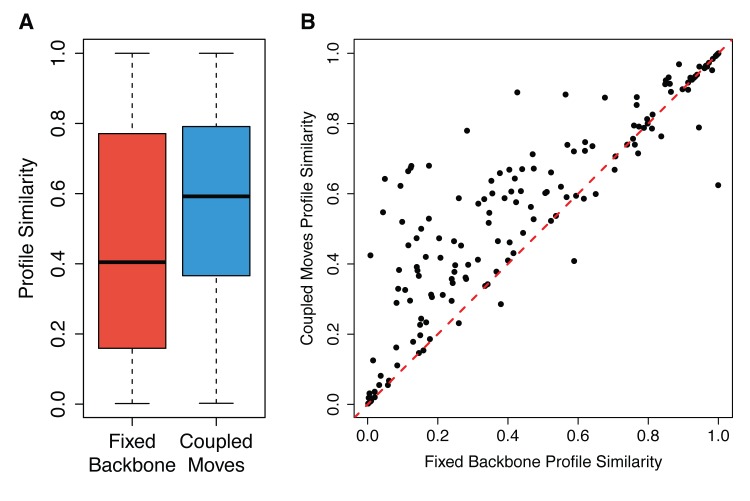
Performance of computational protein design methods on predicting ligand binding site sequences.A) Boxplot of distributions of profile similarity values between natural and designed sequences for each of the 158 positions in 8 co-factor binding sites. Whiskers denote minimum and maximum, top and bottom of the box indicate 75th and 25th percentile, respectively, and the bold line shows the median. B) Scatterplot comparing profile similarity for each position in sequences designed with fixed backbone and coupled moves methods. y = x is shown as a dashed red line. Data points above the diagonal indicate improved predictions using the coupled moves method.